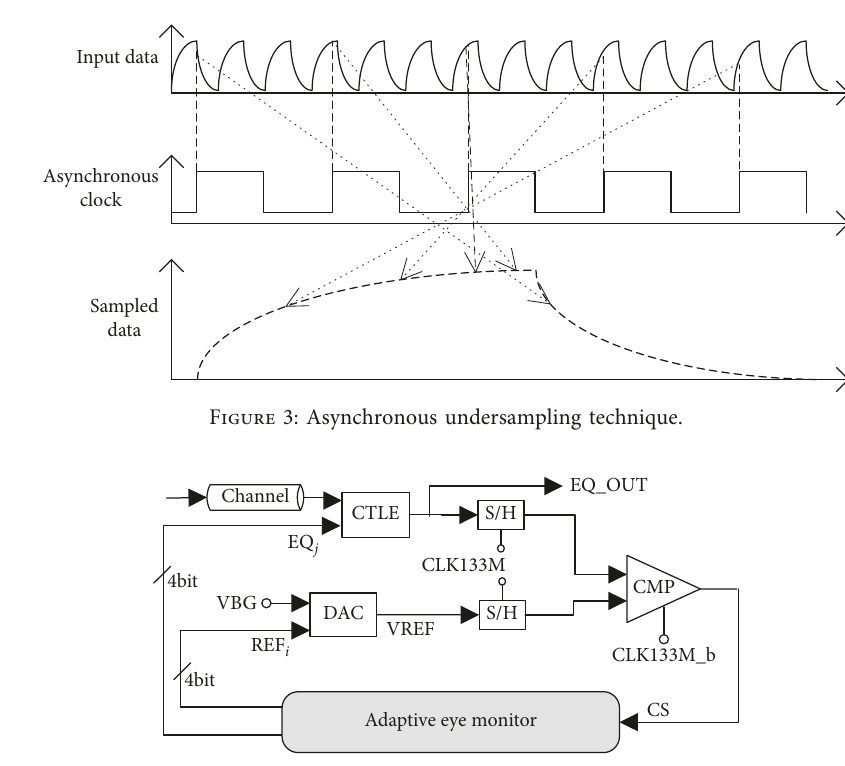
Figure 4: Proposed adaptive equalizer